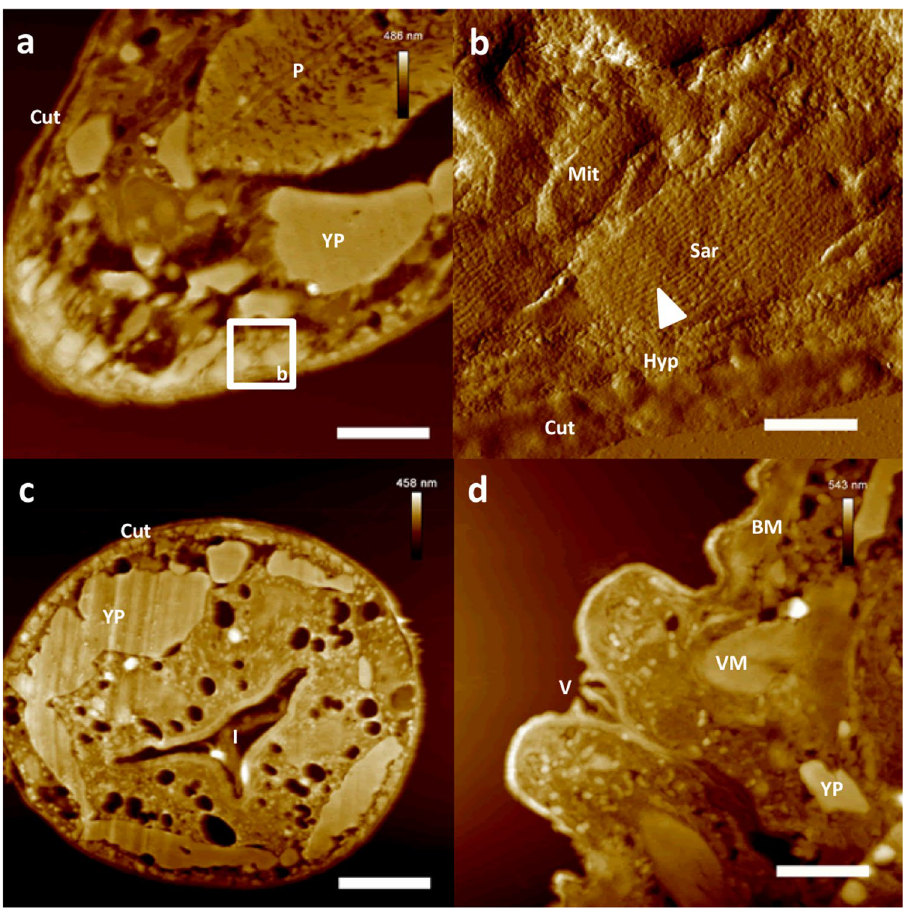
a single body muscle cell (amplitude data shown), with clearly resolved sarcomere morphology. Note the resolution of single myosin filaments (white triangle) within the sarcomere. ( c ) Height data of a cross